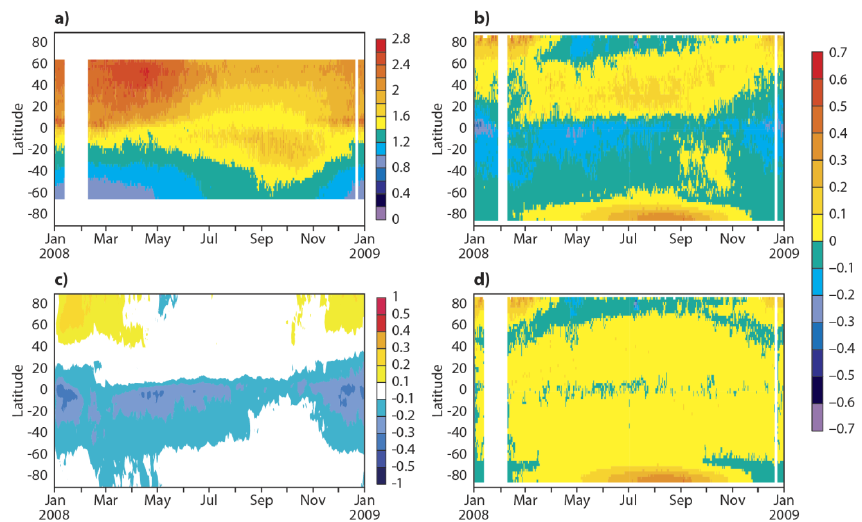
Figure 3. Time series of (a) zonal mean TCCO from the MOPITT data used in CIFS-AN, (b) TCCO analysis departures (observations minus analysis) from CIFS-CTRL and (d) TCCO analysis departures from CIFS-AN, all in 10 18 moleculescm − 2 . Shown in (c) is the zonal mean relative difference in % of CIFS-AN minus CIFS-CTRL. In (a) red indicates higher values of the field, blue lower values. In (b) – (d) red indicates positive values, blue negative values.